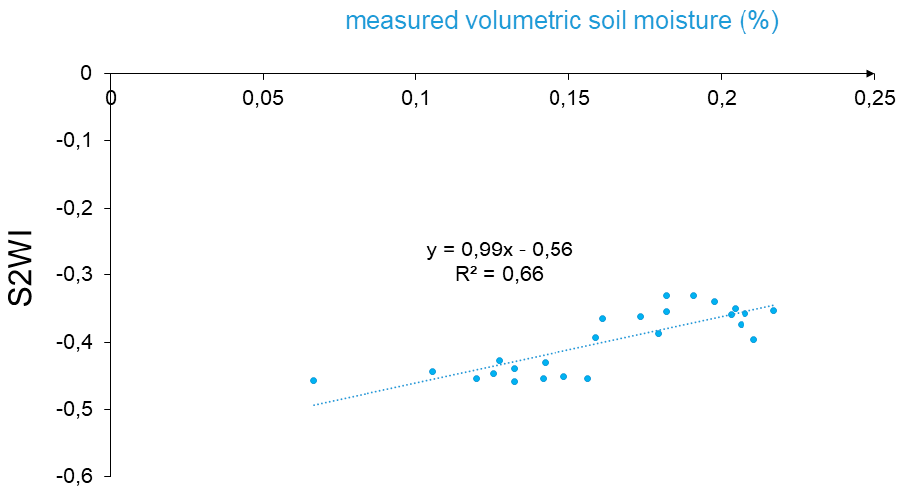
Figure 7. The relationship between the soil moisture index S2WI and the measured topsoil moisture in the field.